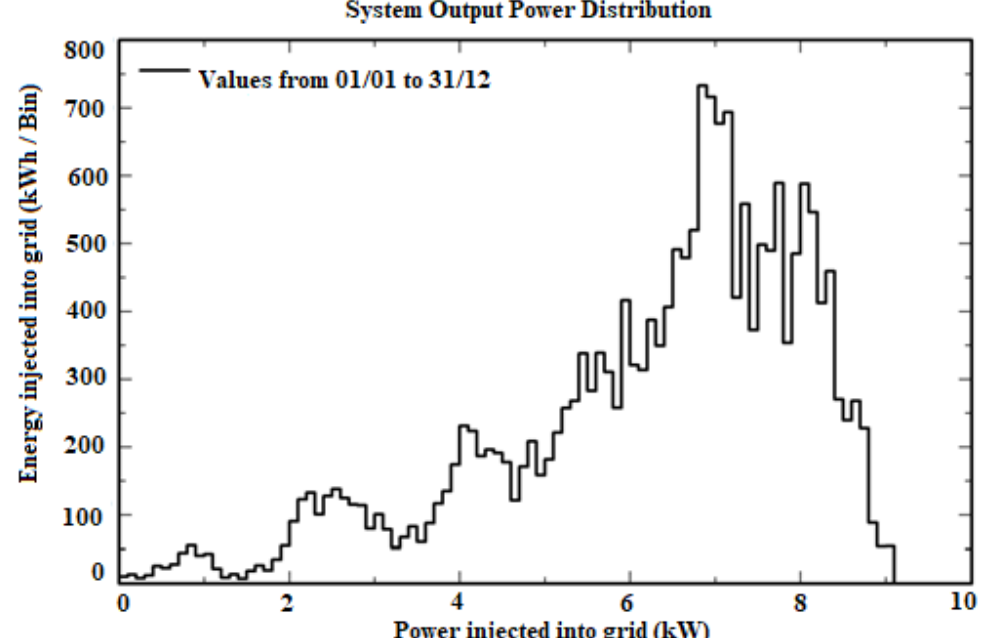
Energies 2023 , 16 , x FOR PEER REVIEW 14 of 22 Figure 8. System output power distribution for the Darab area. Figure 8. System output power distribution for the Darab area.